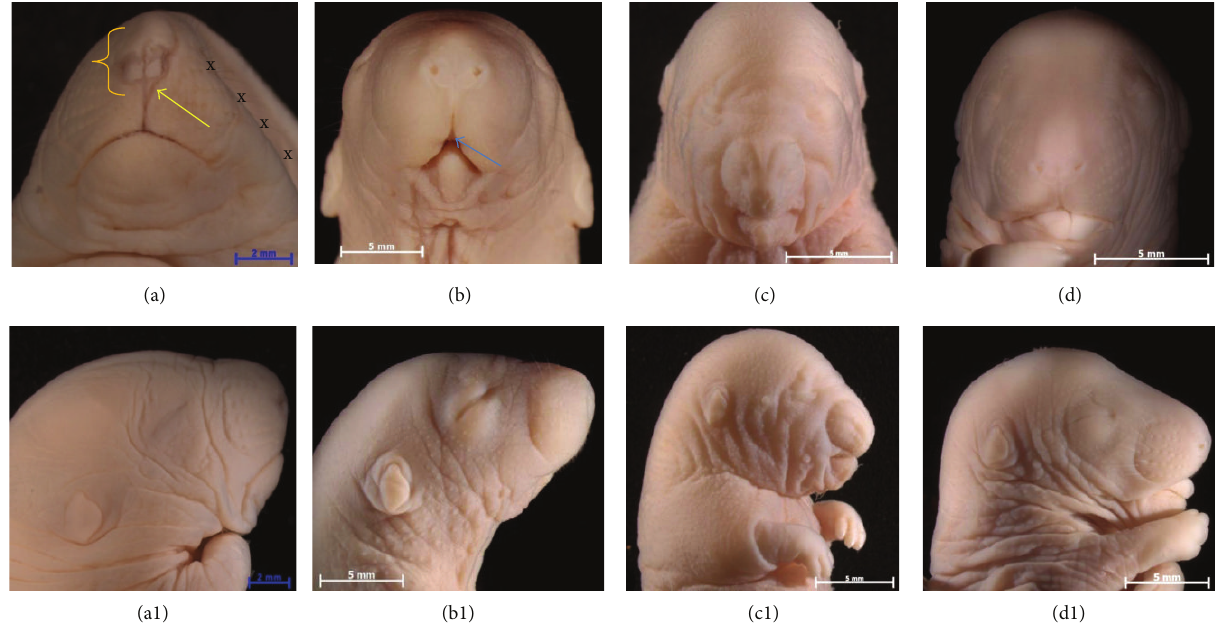
Figure 1: The common craniofacial malformations associated with maternal hyperglycemia. ((a), (a1)) Frontal and sagittal views show hemifacial microsomia with bilateral asymmetry of the left side, malformed facial muscles and bones (xxx), lateral facial cleft (yellow arrow), and bifid nose (bracket). ((b), (b1)) Notice cleft lip-palate (blue arrow) and agnatia. ((c), (c1)) Observe maxillary agenesis. ((d), (d1)) It shows macroglossia. ((a1), (c1), and (d1)) Notice the hypodeveloped eyelids and the nonopen nostrils.